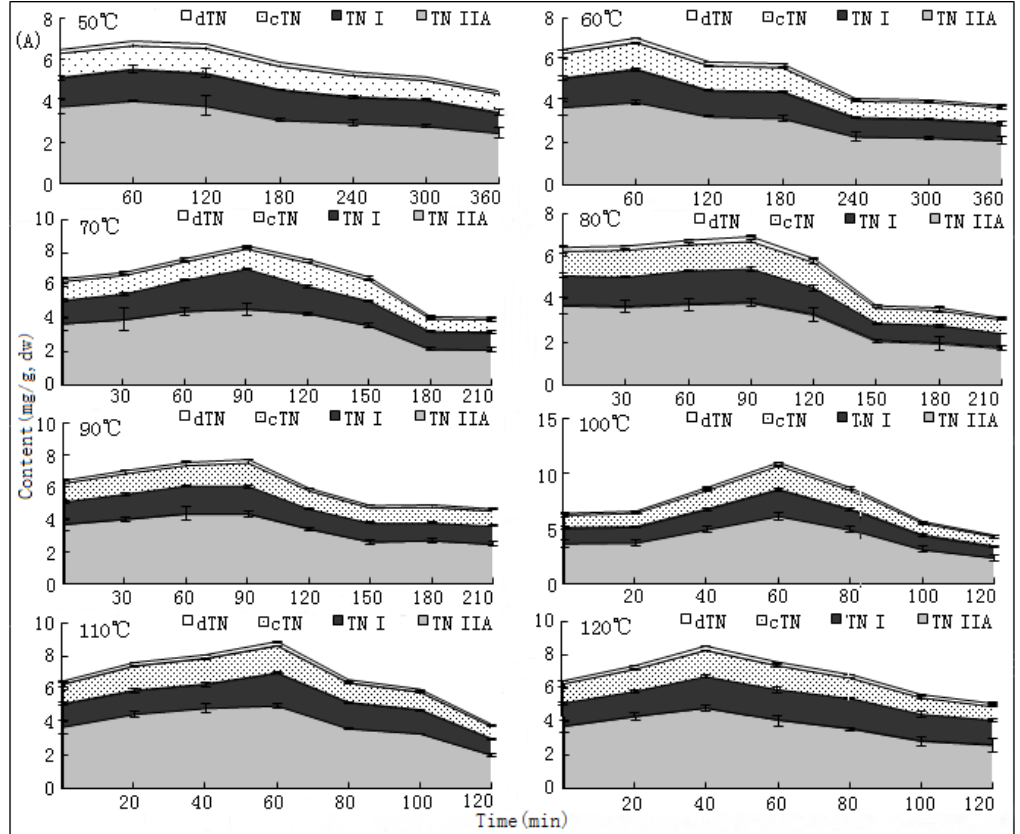
Figure 6. Increases and variation curves of tanshinones during the drying process at different temperature. ( A ) results of experiment 1; ( B ) results of experiment 2; Abbreviations: dTN (dihydrotanshinone I); cTN (cryptotanshinone); TNI (tanshinone I); TNIIa (tanshinone